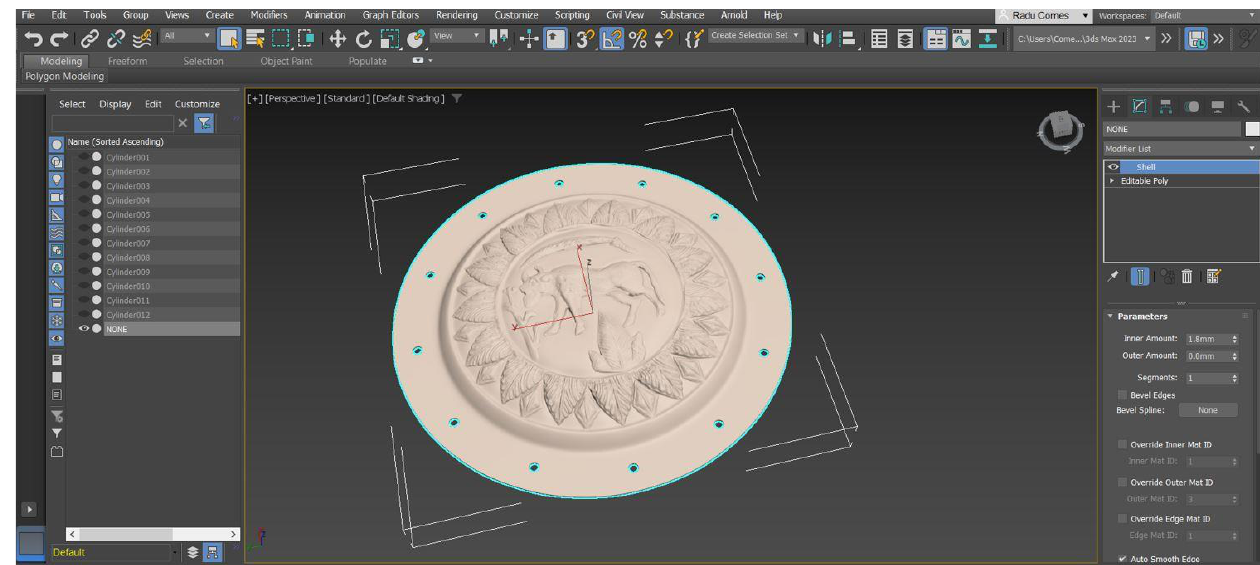
Figure 20. The 3D reconstructed geometry of the fragmented aurochs embossed disk.